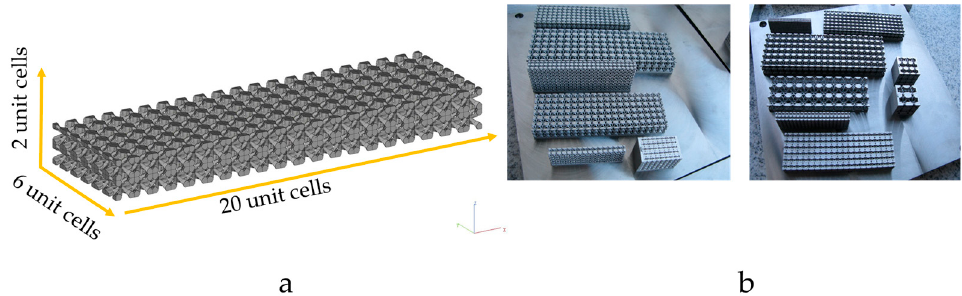
Figure 3. ( a ) Schematic diagram of porous lattice structure; ( b ) porous structures with different unit cell size and porosity manufactured using SLM.